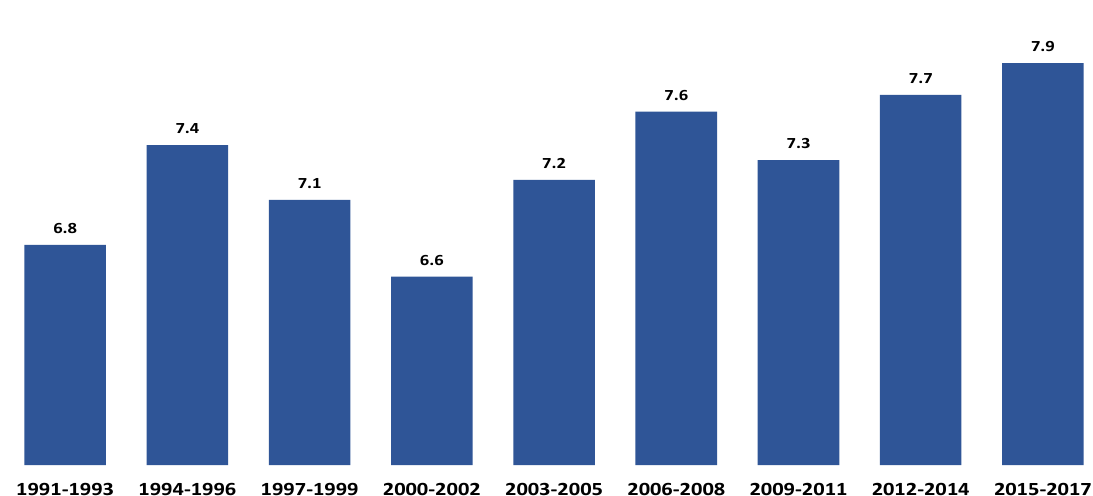
Figure 8: Mean number of years between earning PhD and being promoted to associate professor among newly promoted associate professors by